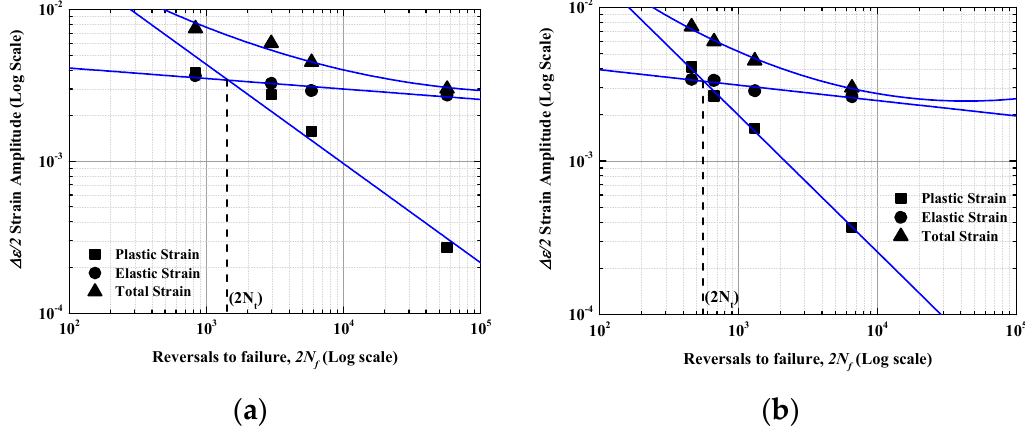
Figure 8. The Coffin ‐ Manson curves of Alloy 617 weldments at ( a ) Room temperature; ( b ) 800 °C condition. Table 4. Coefficients and exponents of Alloy 617 weldments in the Coffin ‐ Manson equation. Temperature